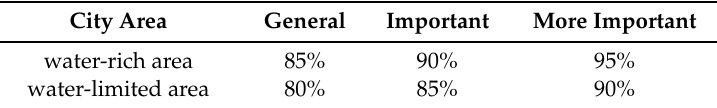
Table 1. Design guarantee rate P .